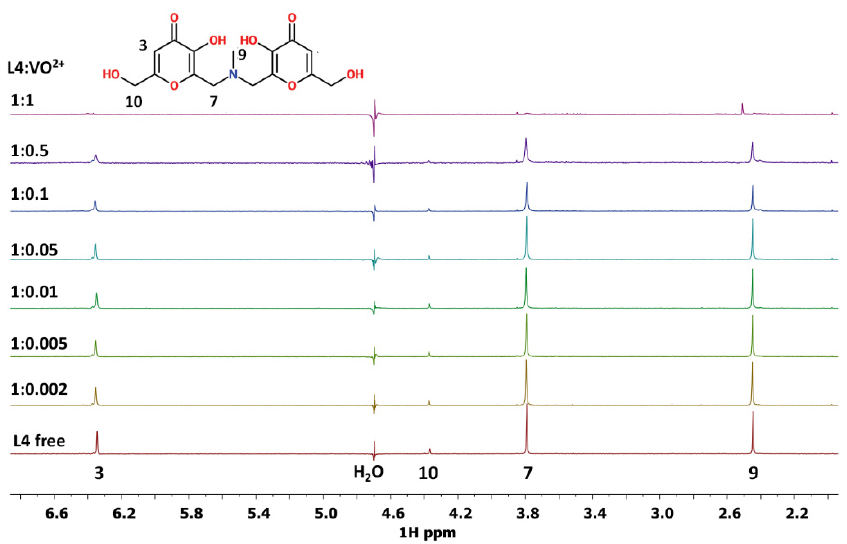
Figure 7. 1D 1 H NMR spectra of L4-V IV O 2+ system in D 2 O at different molar ratios.